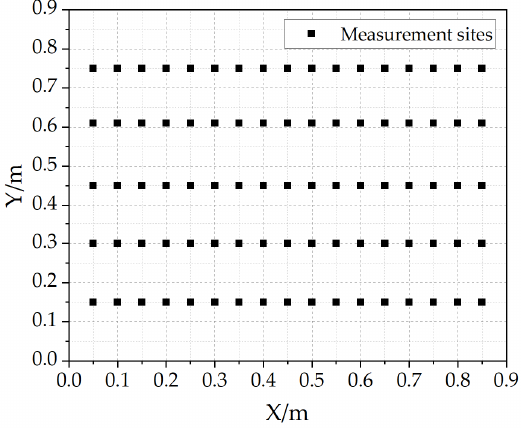
Figure 9. Measurement sites.